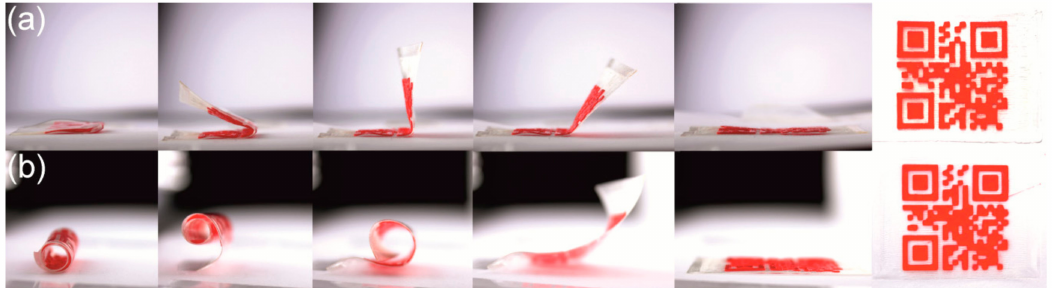
Figure 12. Thermoresponsiveness of type 2 QR code carriers, which were deformed in a folding approach ( a ) and a rolling approach ( b ): Programmed shapes (left), sequential shape recovery when placed on a 60 ◦ C hot heating plate (images 2–4) and recovered shapes (images